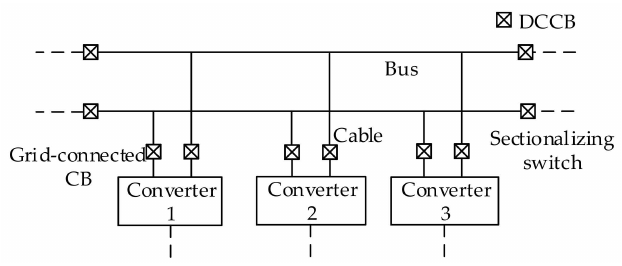
Figure 3. A protection zone in proposed